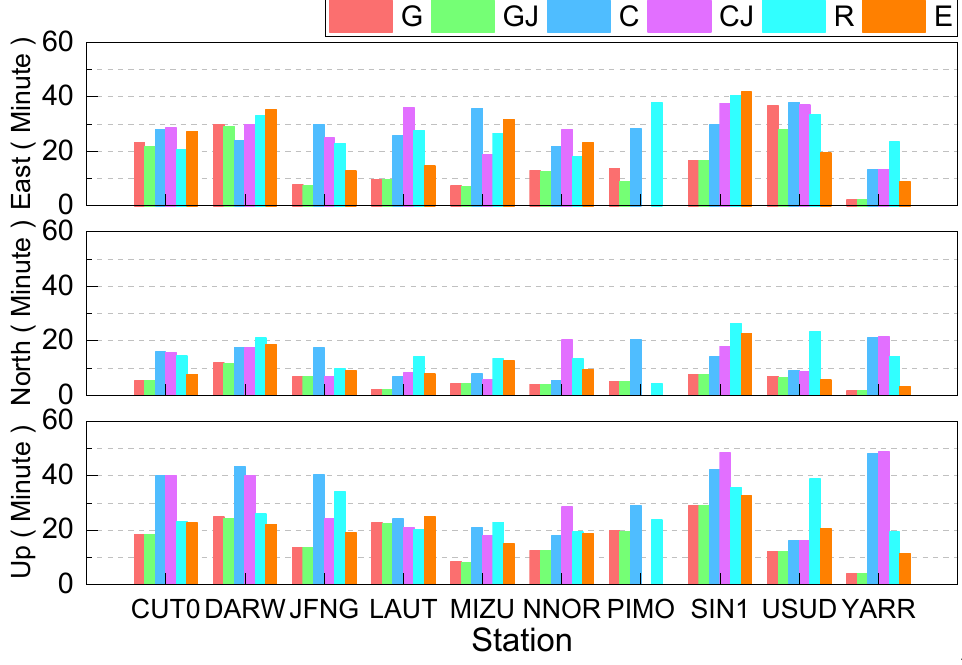
Figure 9. Mean convergence time for static PPP in each station. Table 6. Convergence time and positioning accuracy of different combination static